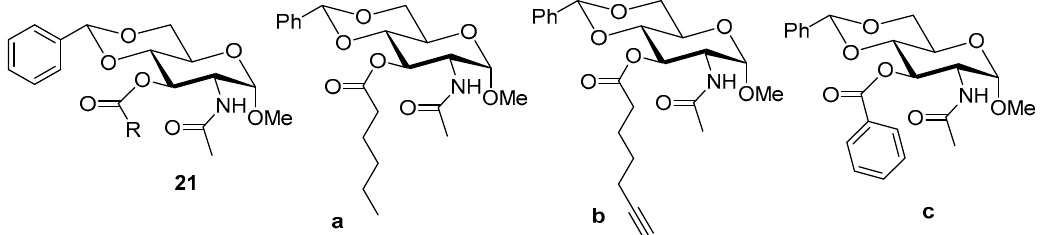
Figure 14 . Structures of C-3 ester derivatives of the NAG headgroup [53].